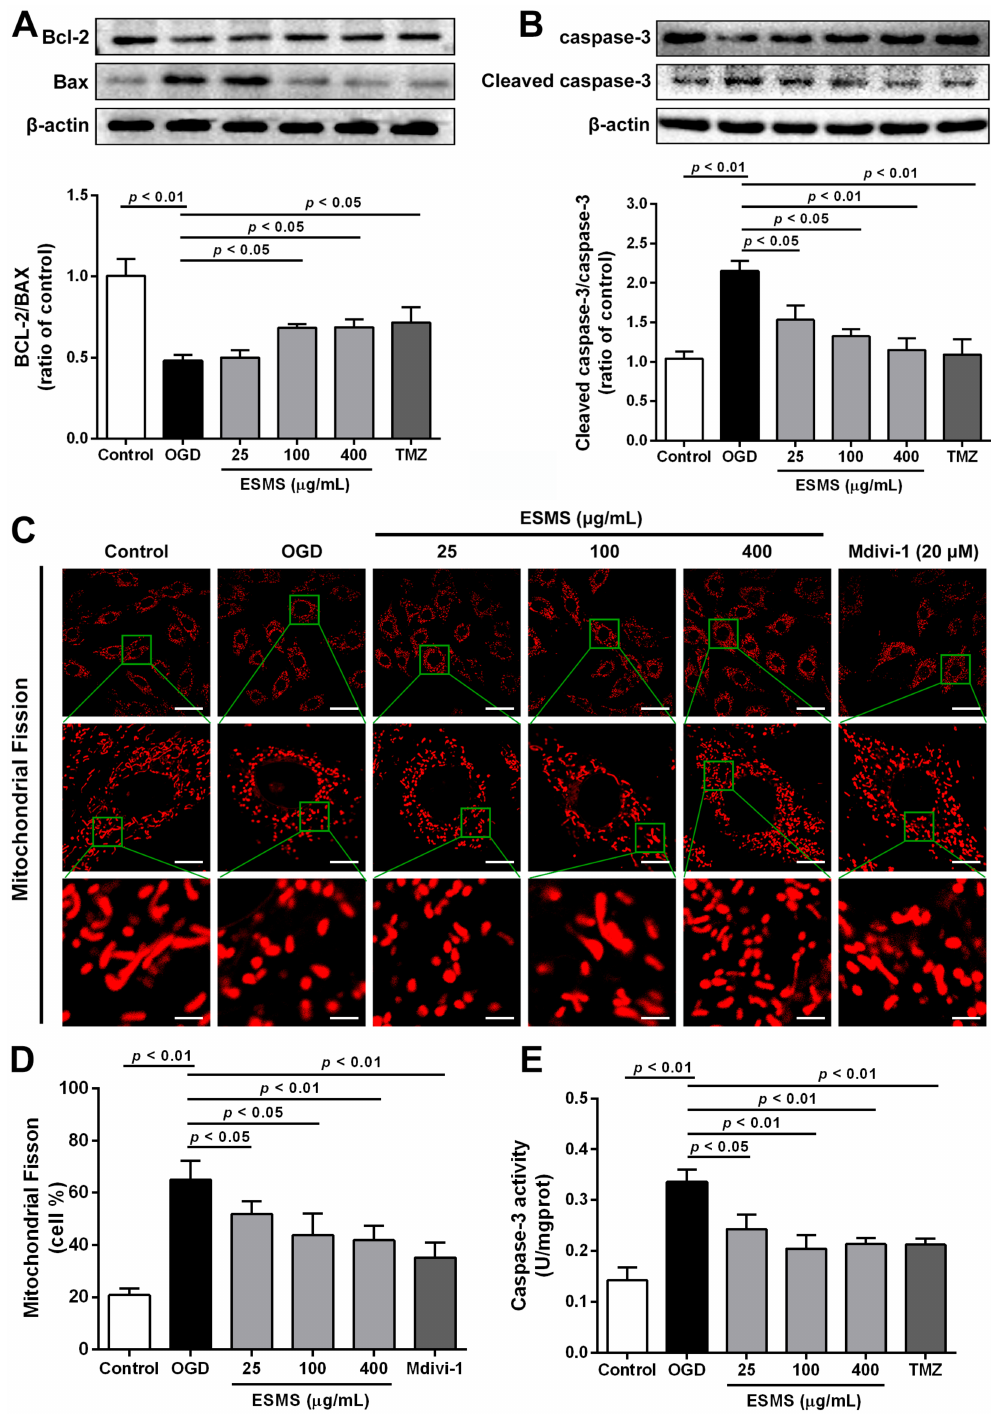
Figure 7. ESMS ameliorated the expression of mitochondrial mediated apoptosis proteins and reduced the caspase-3 activity in H9c2 cells subjected to OGD. ( A ) Bcl-2 and Bax expression were detected by Western blot ( n = 3); ( B ) Caspase-3 protein expression was measured by Western blot ( n = 3); ( C ) Mitochondrial fission was detected by Mito Tracker ® Deep Red FM with a confocal laser scanning microscope. Bars are 40 µ m for top, 10 µ m for middle and 4 µ m for bottom ( n = 3); ( D ) Quantitative analysis of mitochondrial fission ( n = 3); ( E ) Caspase-3 activity of all groups was evaluated ( n = 6). Results were presented as mean ± SD. TMZ = Trimetazidine dihydrochloride (positive